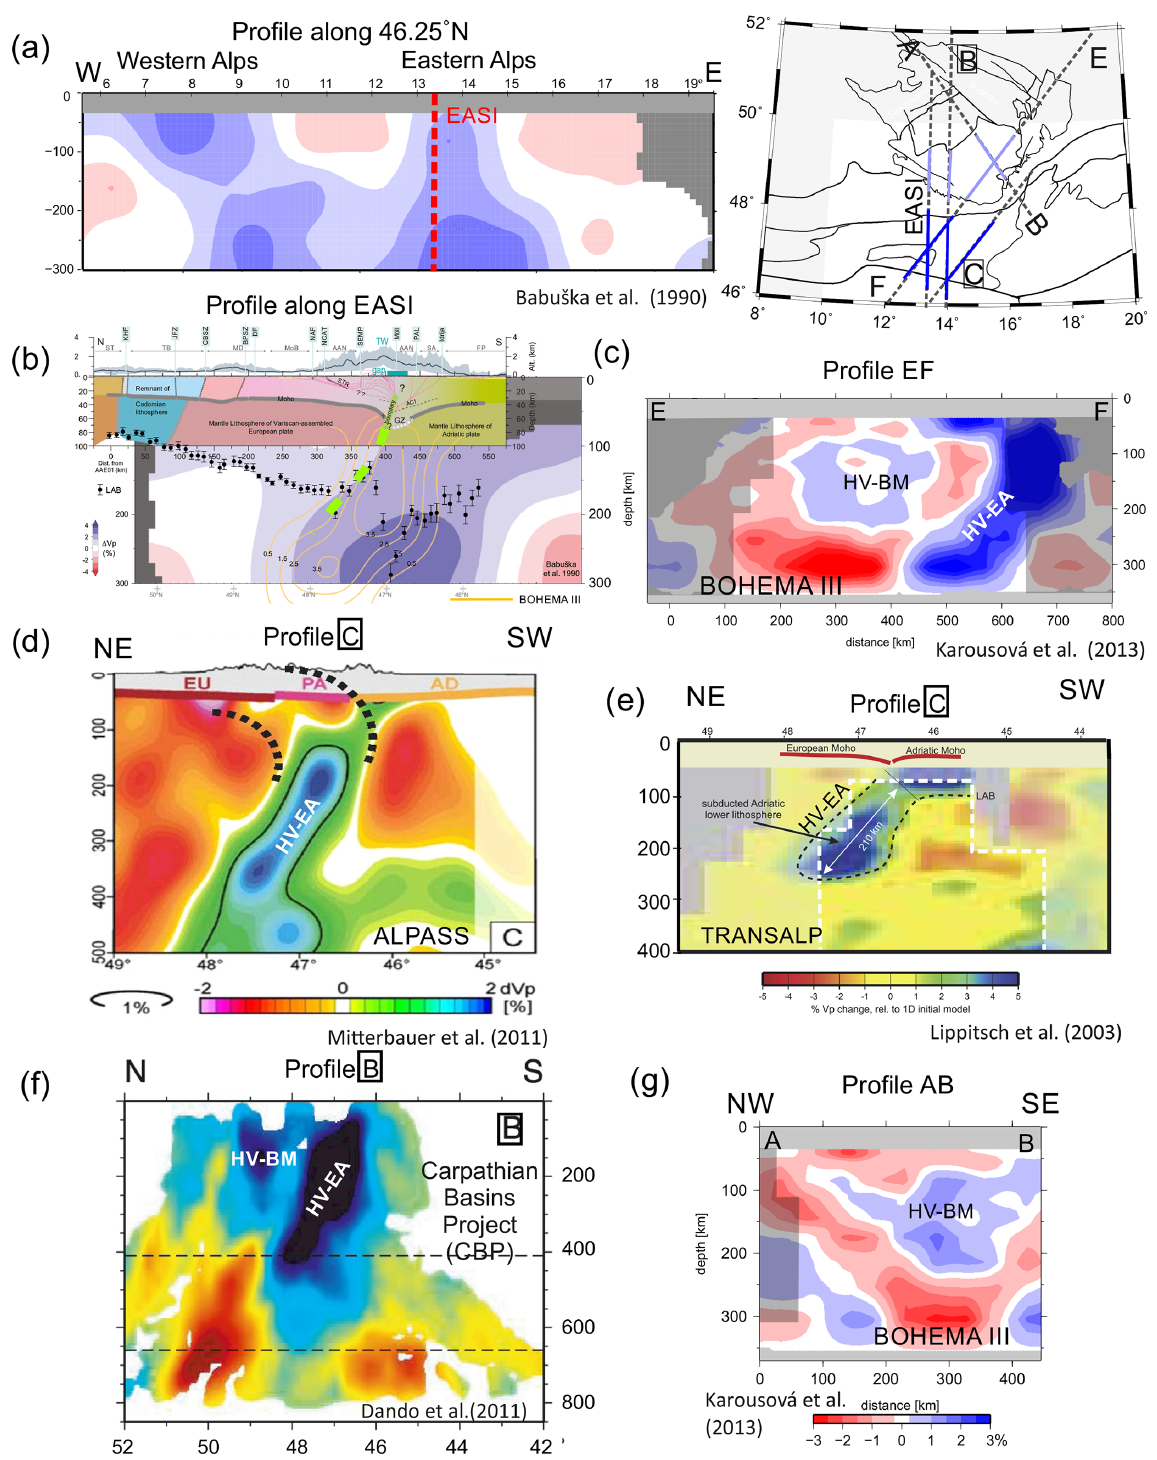
Figure 5. Cross sections through various regional teleseismic P-wave tomography results showing segmentation of the Western and Eastern Alps and changes in the slab dip directions (a, b) , the northward dip of the steep slab (HV-EA) beneath the Eastern Alps (b–f) , and the small-sized HV-BM heterogeneity beneath the Bohemian Massif (c, f, g) . Cross sections (a, b) from Babuška et al. (1990), with the crust in (b) from Hetényi et al. (2018b) and perturbation contours in (b) from Karousová et al et al. (2013). The profile locations in map view are in the upper right. The dark and light blue highlights refer to the location of the positive perturbations beneath the Eastern Alps and the Bohemian Massif (HV-EA and HV-BM), respectively. The full set of colour palettes can be found in the original publications.